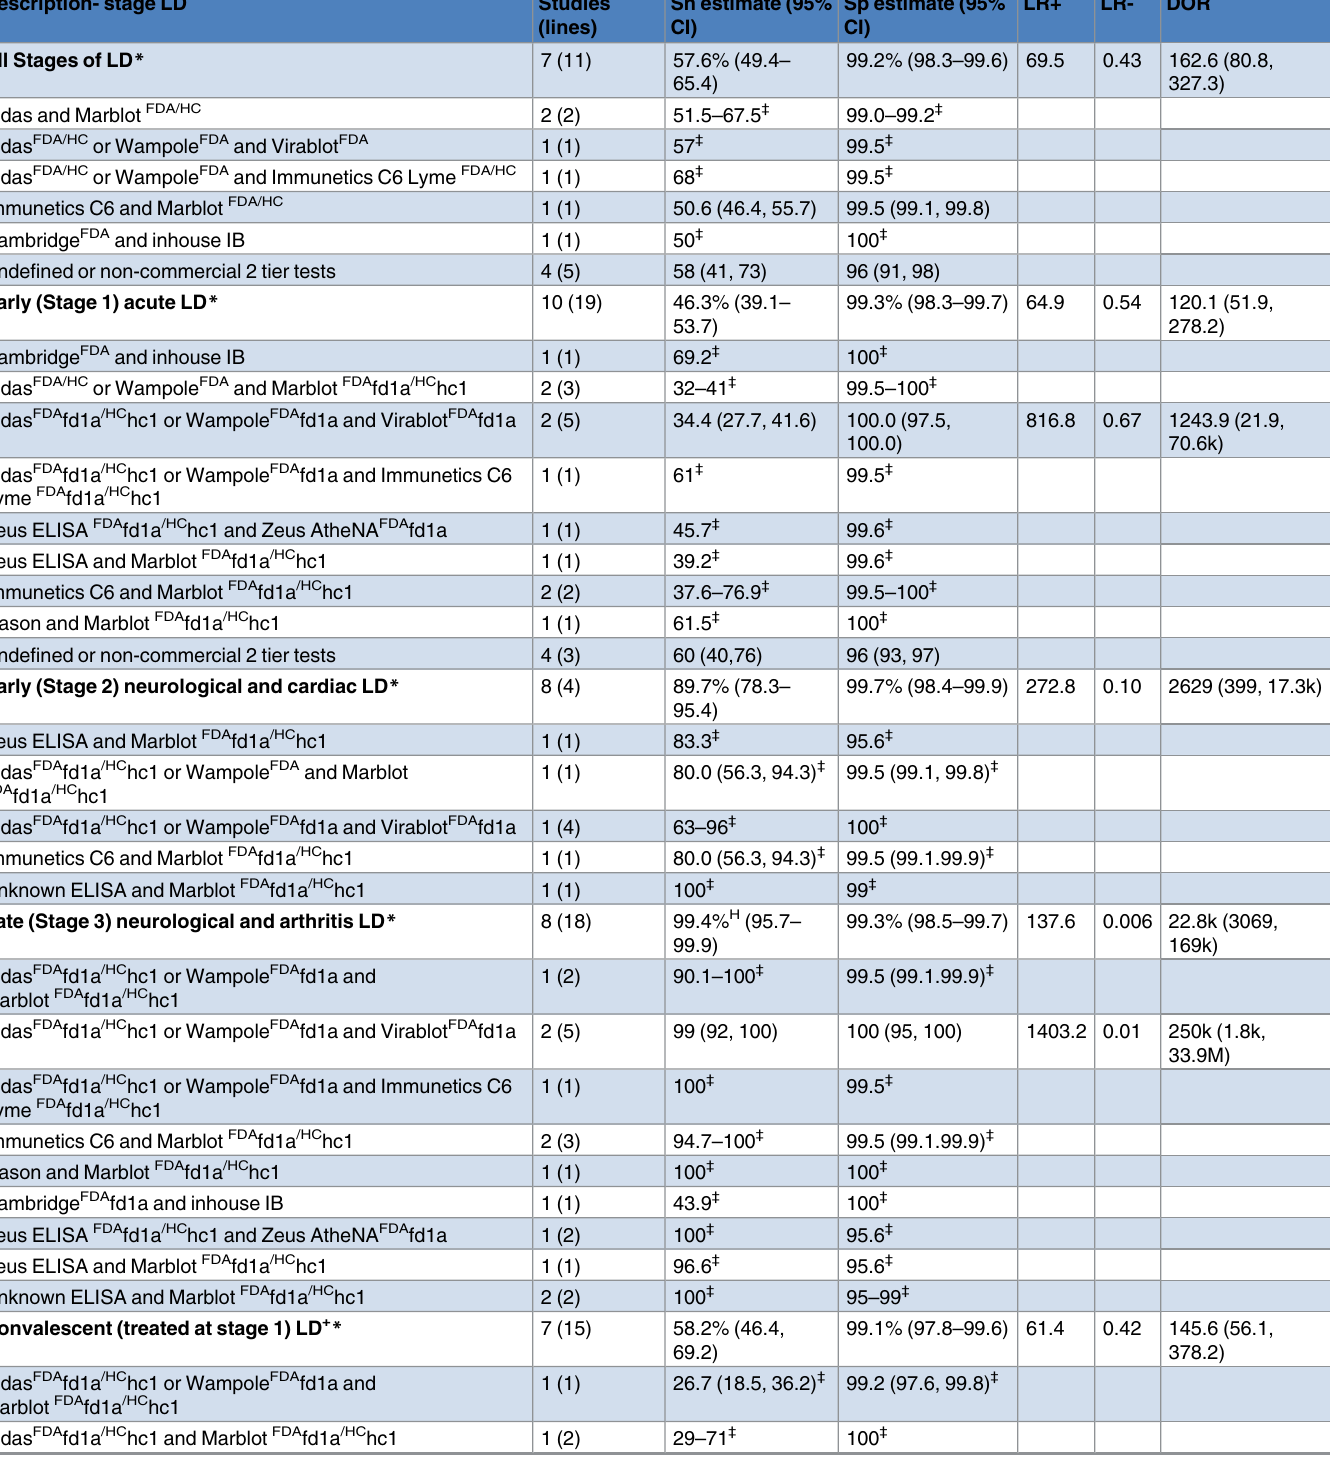
Table 2. Thirteen studies (78 lines of data) evaluating a two-tier serological test protocol summarized by the stage of Lyme disease tested using a hierarchical logistic regression model in Stata 13 or the range of sensitivity and specificity data presentedin the paper when less than four lines of data were available for